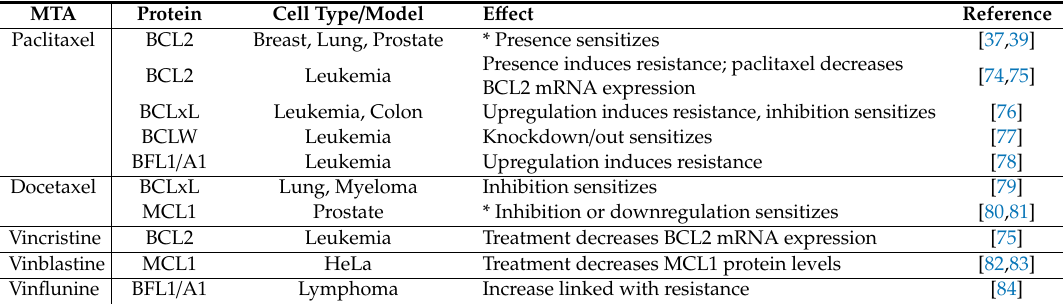
Table 1. MTA E ffi cacy and sensitivity within the context of the anti-apoptotic BCL2